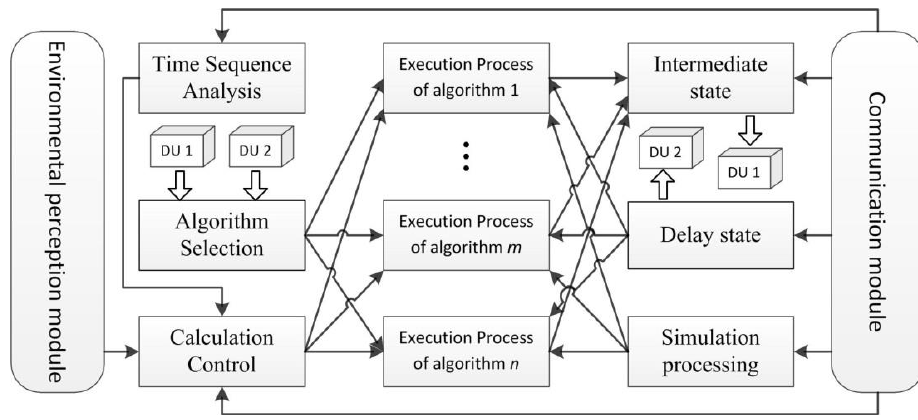
Figure 2. The data engine control component performs a multi-agent structure.